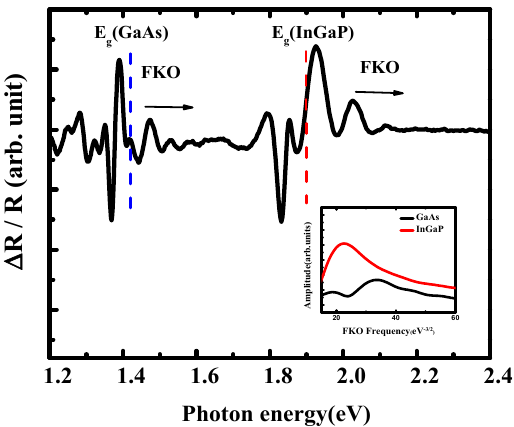
Figure 3. The PR spectra of InGaP/GaAs dual junction solar cell at room